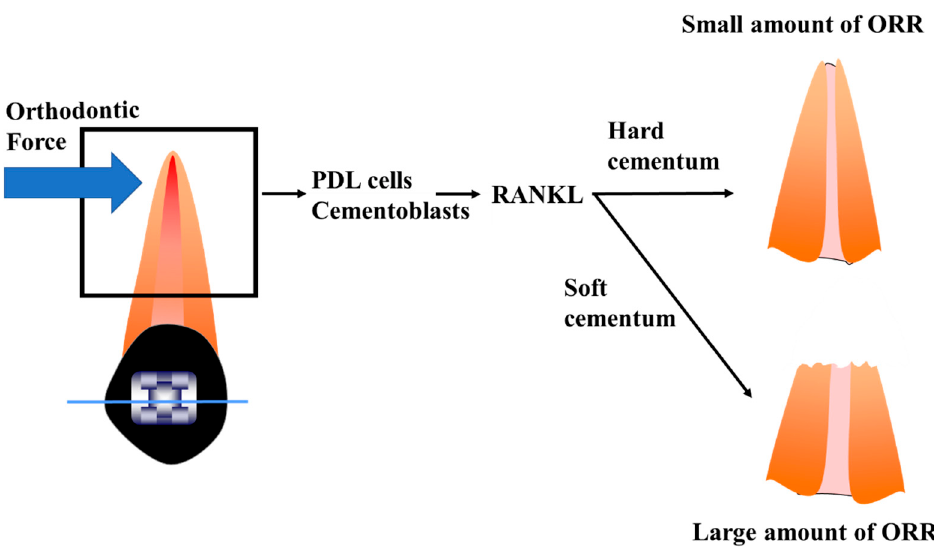
Figure 4. Schematic figure showing the presumed role of cementum in ORR. Despite a similar amount of RANKL expression, teeth with hard cementum may present with less root resorption than those with soft cementum. Thus, hard cementum may be the last defense against ORR.